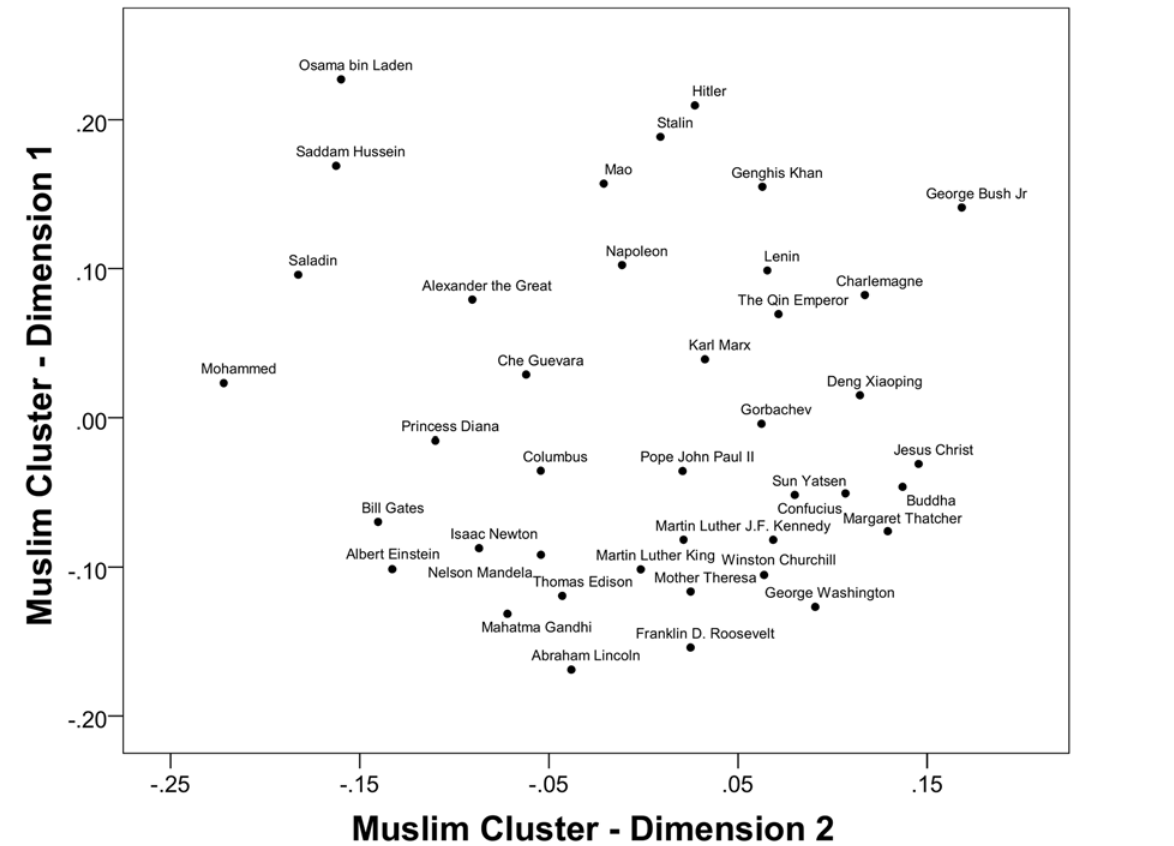
Fig 4. Rotated MDS solution for the Muslim (Indonesia, Malaysia, Pakistan, Tunisia) cluster with all 40